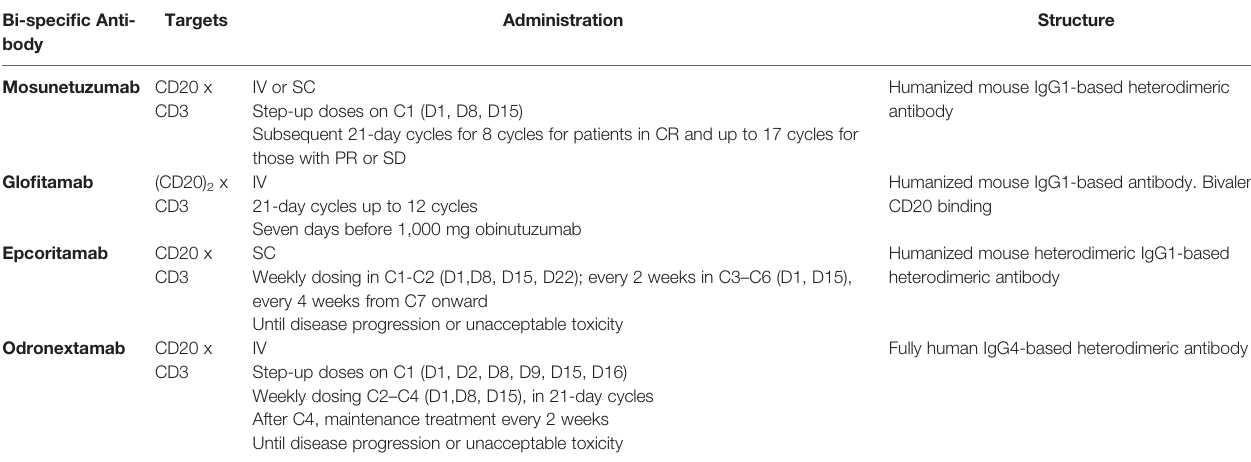
TABLE 1 | Structure of IgG-like bi ‐ speci fi c